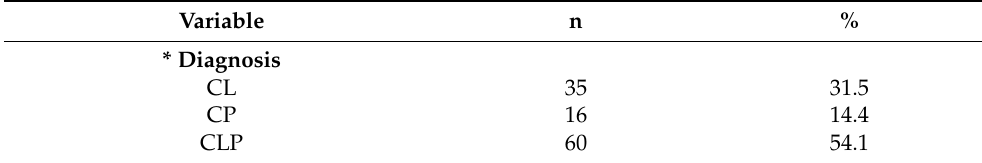
Table 1. Demographic characteristics of patients with